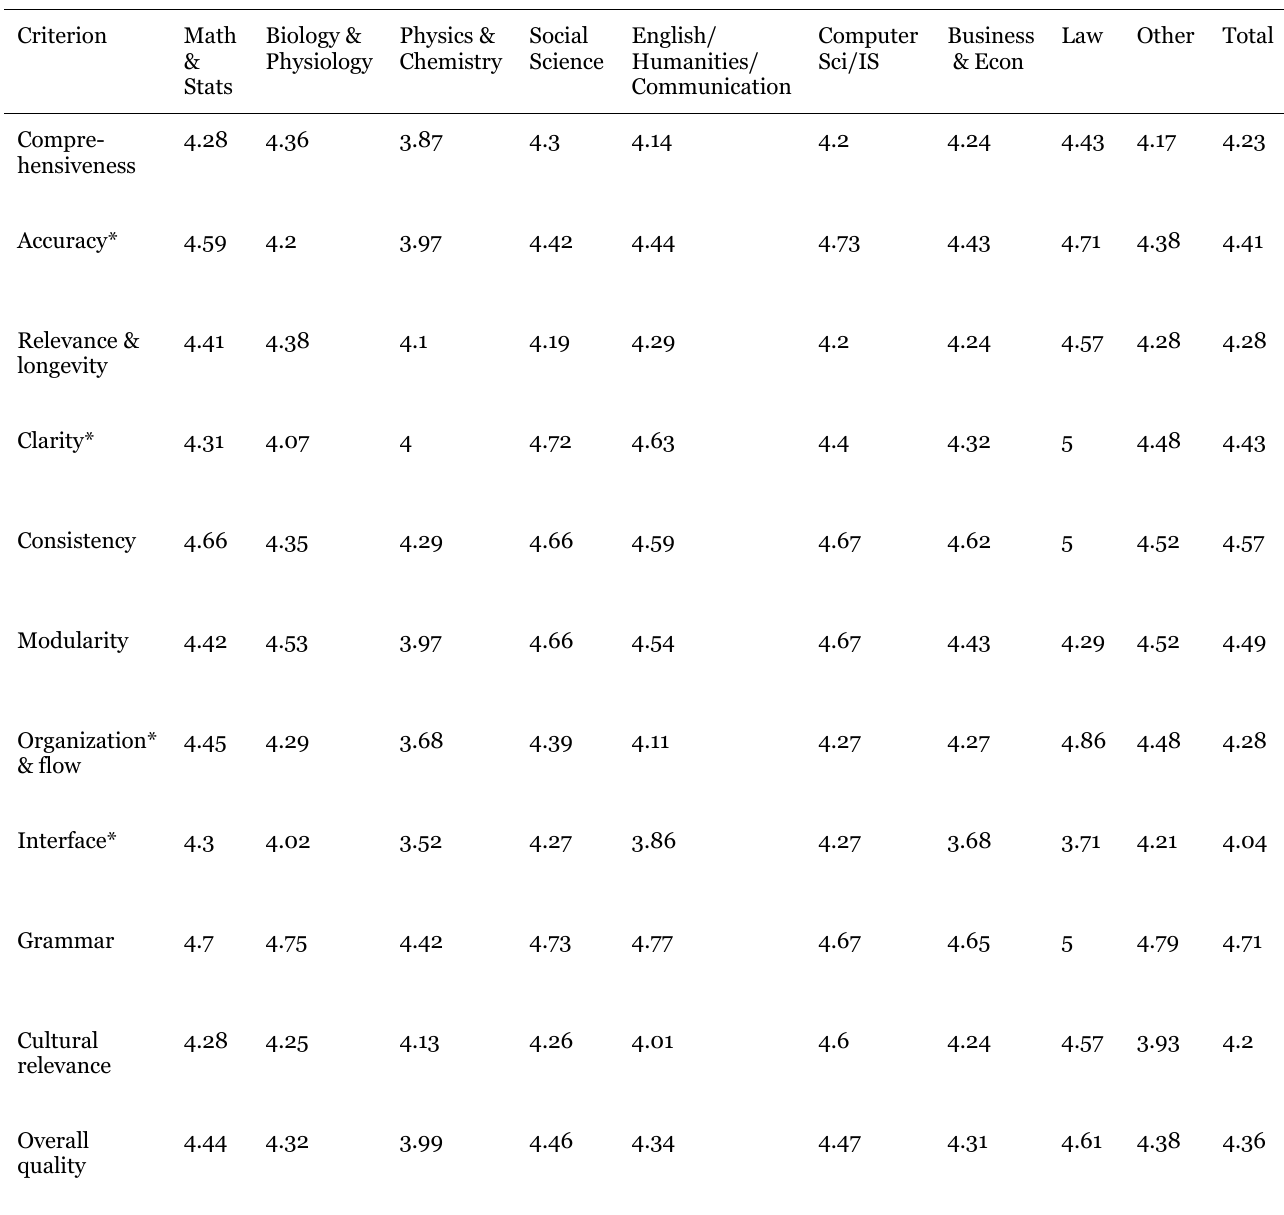
Mean Ratings by Text